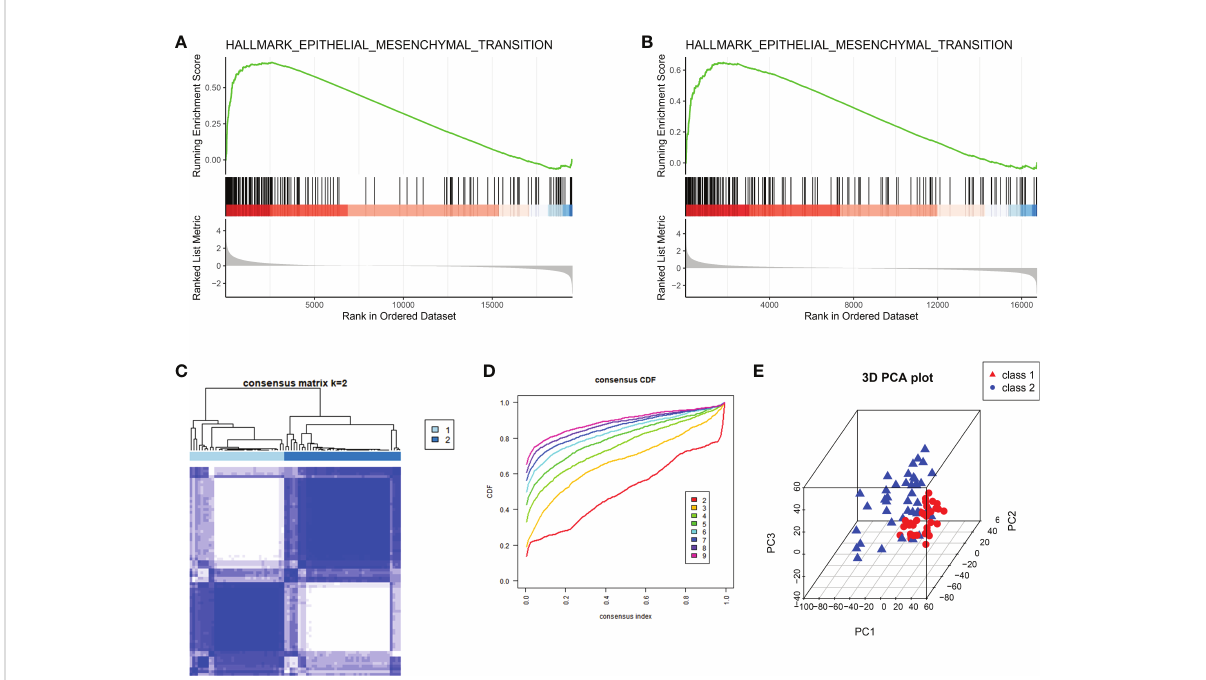
FIGURE 1 The classi fi cation of peritoneal endometriosis based on EMT. (A, B) . GSEA analysis of the whole transcriptome of GSE141549 and GSE5108, respectively. (C) . EMT modi fi cation patterns identi fi ed with K-means clustering. (D) . The cumulative distribution function (CDF) curve of the clustering. (E) . PCA plot of cluster1 and cluster2.